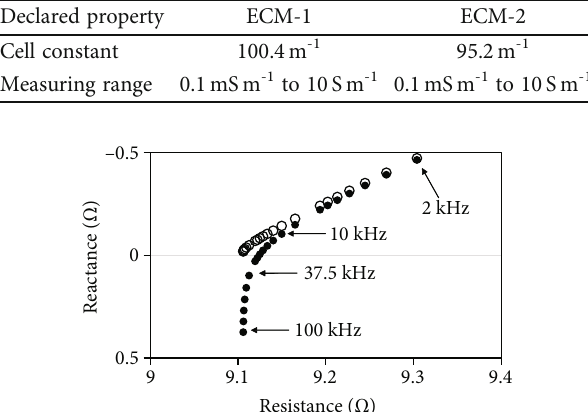
Figure 2: Examples of impedance spectra measured by ECM-2 with 1molkg -1 KCl aqueous solution in the frequency range from 2kHz to 100 kHz. Closed circles are measured values; open circles are measured values subtracting the calculated inductance component.